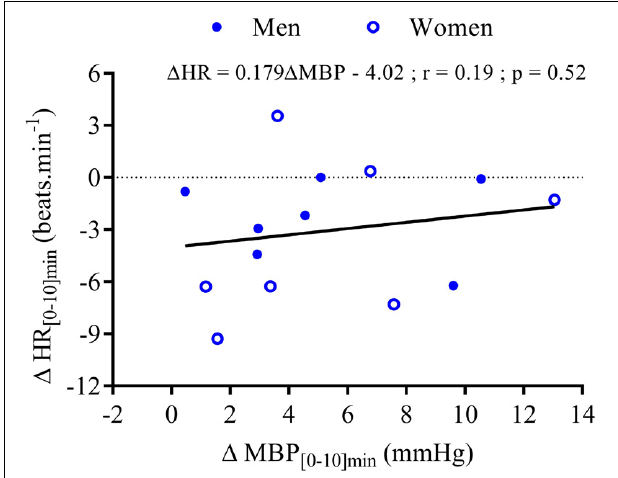
FIGURE 7 | Correlation analysis between the changes in mean HR and the changes in MBP during the first 10 min after wine ingestion for seven men